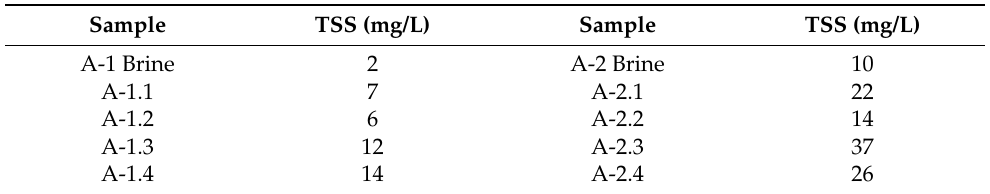
Table 9. Comparison of total suspended solids (TSS) on PETRONS brine & water permeability effluent of PETRONS samples.